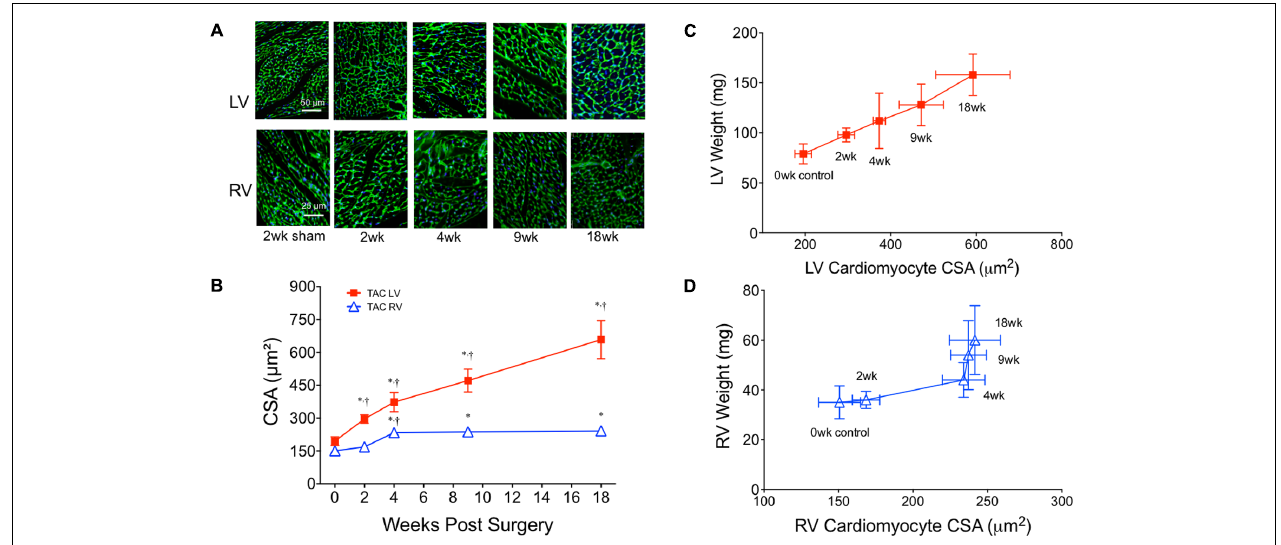
FIGURE 5 | Cardiomyocyte cross-sectional area (CSA) from both the left (LV) and right (RV) ventricles over 18 weeks of TAC. (A) Representative images from the LV (top row) and RV (bottom row) stained with wheat germ agglutinin-3. (B) Averaged cardiomyocyte CSA over 18 weeks of TAC ( n = 6 for each point). Complete sham CSA data is presented in Table 4 . Correlation plots between ventricle weight and CSA in the (C) LV and (D) RV. ∗ p < 0.01 vs. age-matched sham. † p < 0.01 vs. previous time point.